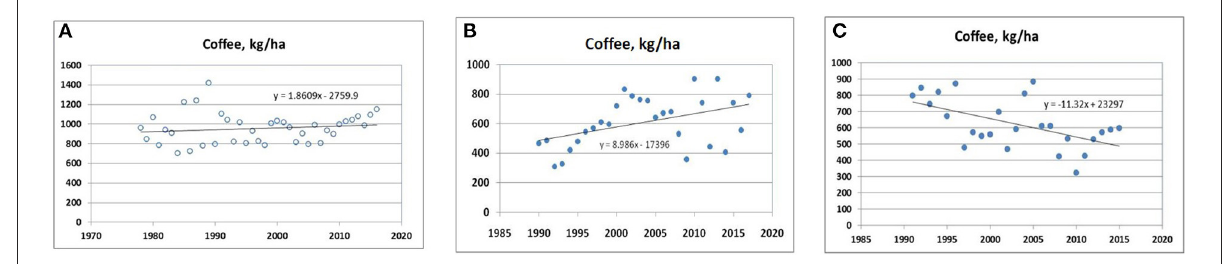
FIGURE5 Coffee productivity trend. (A) Kodagu hills (Karnataka); (B) Cardamom hills (Kerala); (C) Lower Pulney hills (Tamil Nadu).